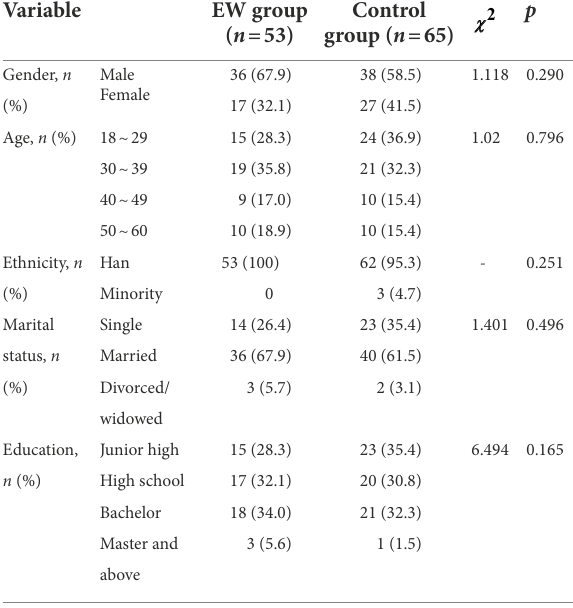
TABLE 2 Comparison of general information between two groups (case).